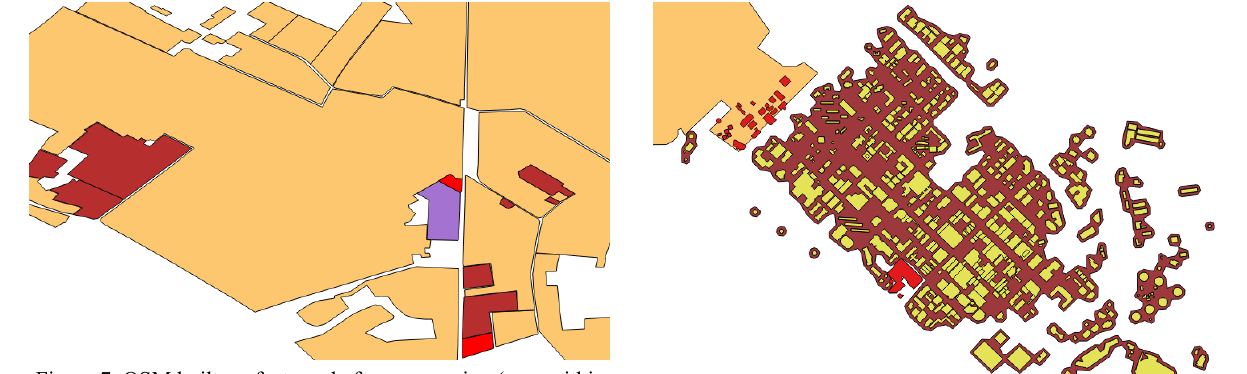
Figure 7. OSM built-up features before processing (area within Oldenburg, Germany) Figure 10. OSM buildings (red: removed buildings intersecting resulting polygons of algorithm 1 [depicted in light orange]; green: remaining buildings) and the resulting built-up areas (in brown) computed with an initial buffer distance x of 25m and a generalization distance of 5m (area of Darwin, Australia)